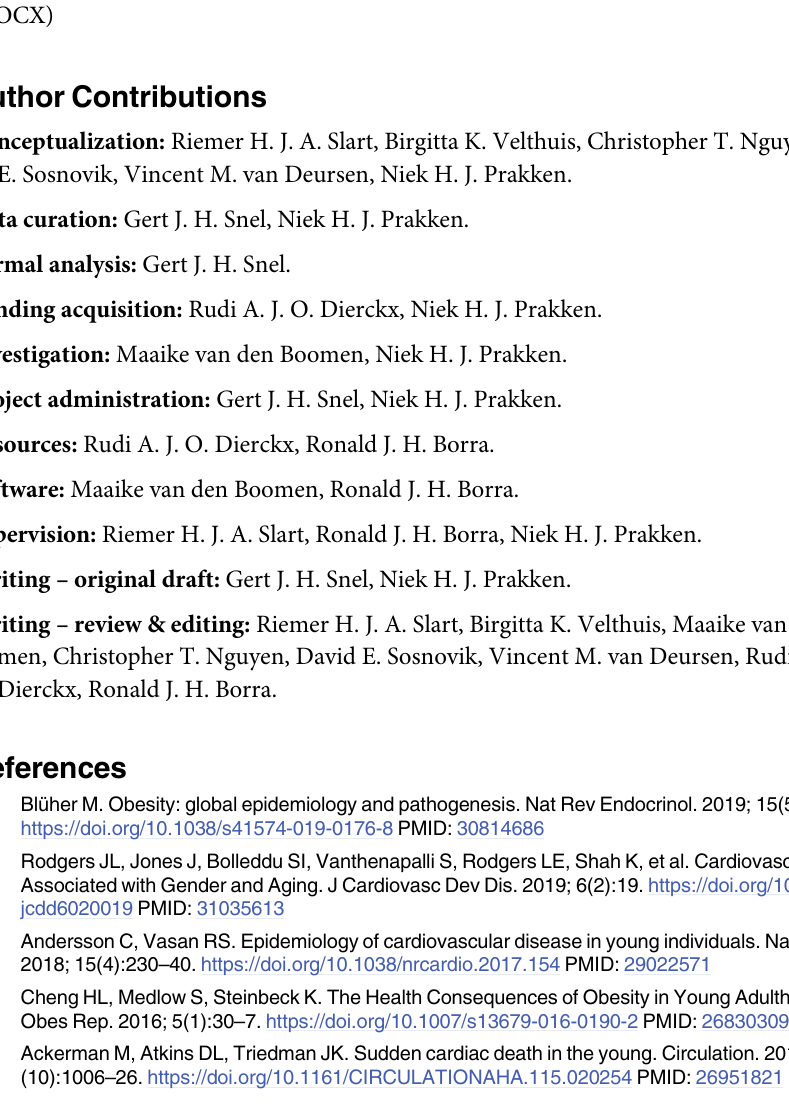
S6 Table. Cardiac morphology and function in normotensive females divided on BMI. mild overweight BMI body mass index. S7 Table. Cardiac morphology and function in hypertensive subjects divided on BMI. Data reported as mean ± standard deviation. � P < 0.05 versus normal-weight, †P < 0.05 versus mild overweight BMI body mass index. S8 Table. Indexation of volumes and mass for different body scales. Data reported as mean ± standard deviation. � P < 0.05 versus normotensive normal-weight. S9 Table. Differences between hypertensive subjects on presence anti-hypertensive medi- cation. Data reported as mean ± standard deviation. Indexed indexed with body surface area, EDV end-diastolic volume, ESV end-systolic volume, SV stroke